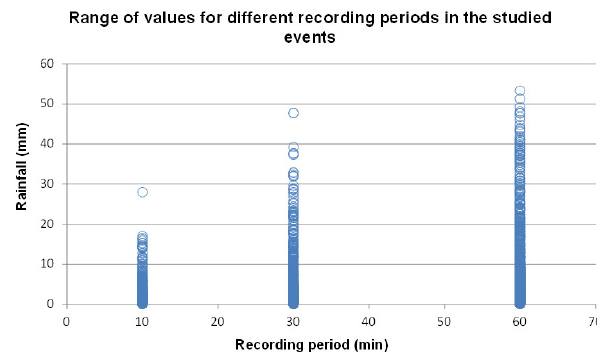
Figure 7. Range of values for the 10, 30 and 60min period in the studied events.